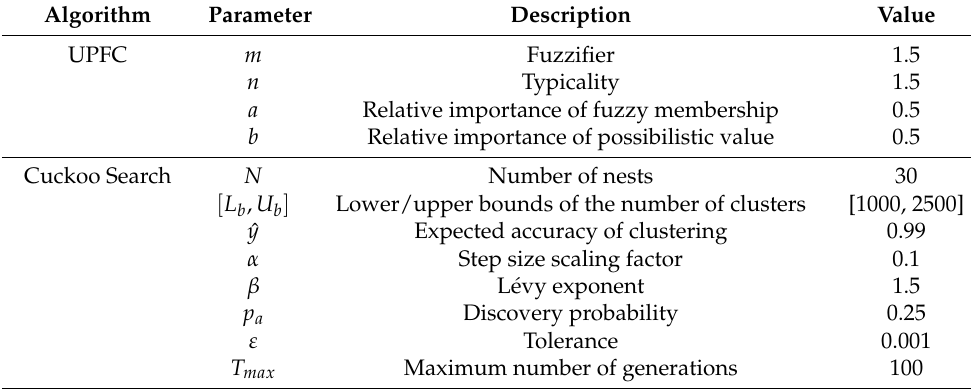
Table 2. List of UPFC and cuckoo search